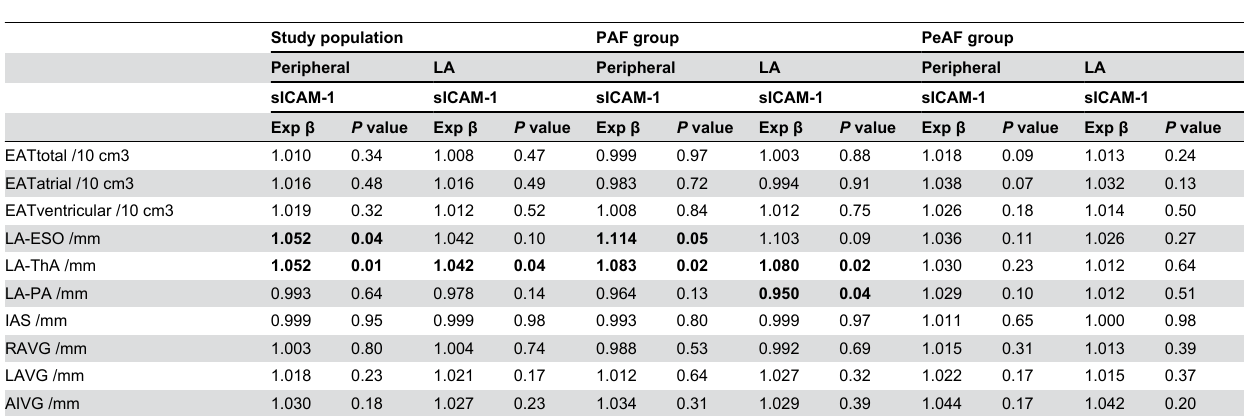
Table 4. Multivariable Models with Peripheral and LA Blood Levels of sICAM-1 as the Dependent Variable.